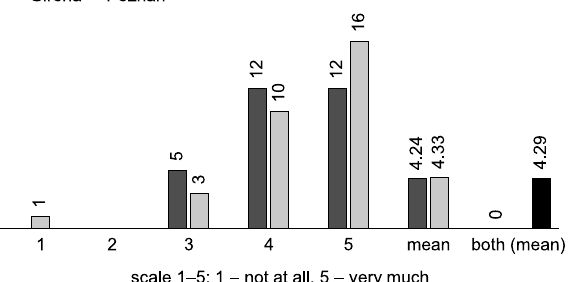
Fig. 3. Students’ satisfaction with the LBD method – the overall quality of teaching.